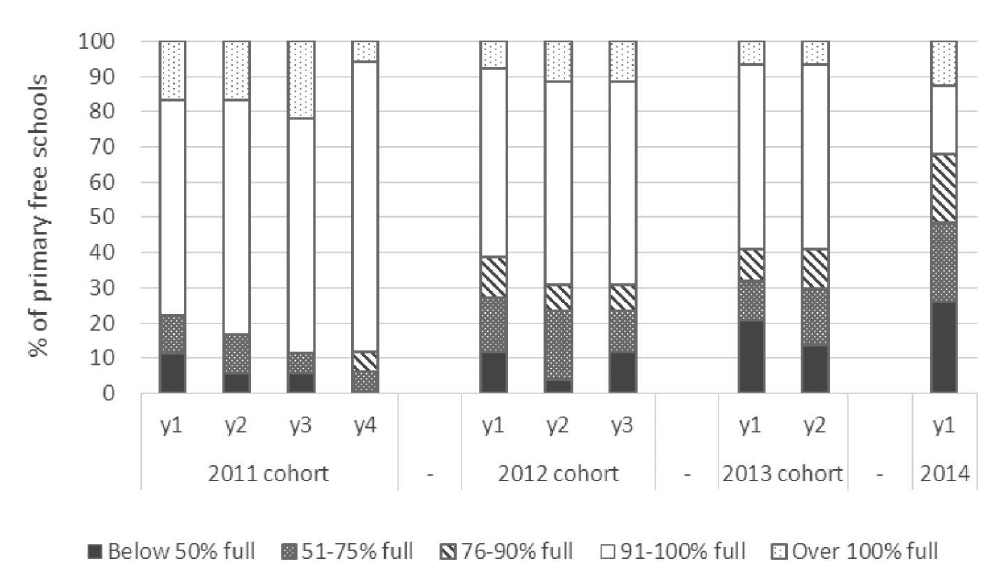
Figure 5: Percentage of spaces filled in Year R